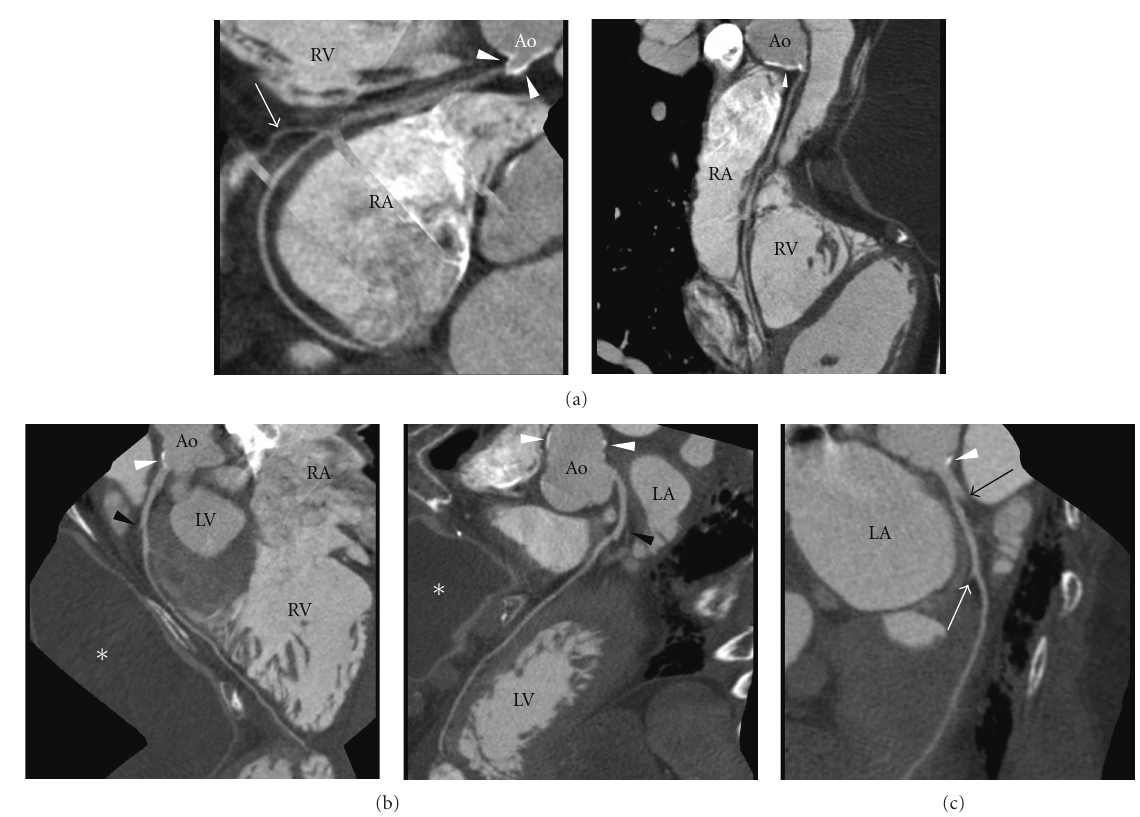
Figure 1: 48-year-old female with history of childhood lymphoma treated with mediastinal radiation therapy and anthracycline chemotherapy atage 12, presented with fatigue and decreased left ventricular ejection fraction by echocardiogram. Coronary CT angiography shows nonobstructive coronary plaques and supports the diagnosis of chemotherapy-induced cardiomyopathy. (a) Curved reformat view of the right coronary artery (RCA) shows nonocclusive calcific ostial plaque (arrowheads) calcific plaque in the aortic root. The first acute marginal branch is identified (arrow). Also noted are misregistration artifacts. (b, c) Curved reformat views of the left anterior descending (LAD) (b) and circumflex (c) coronary arteries show calcific plaque (white arrowhead) in the aortic root at the origin of the left main coronary artery. The first diagonal artery (black arrowhead) is identified on the LAD view (b). The LAD origin (black arrow) and distal circumflex artery continuation (white arrow) are identified on the circumflex view (c). No significant narrowing is seen in any of the major coronary arteries. LA = left atrium. LV = left ventricle. RA = right atrium. RV = right ventricle. Ao = Aortic root. ∗ = breast